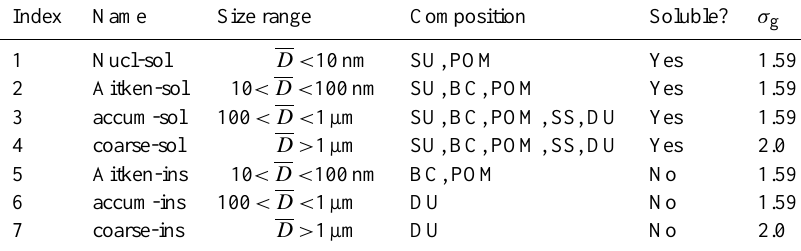
Table 3. Standard aerosol configuration for